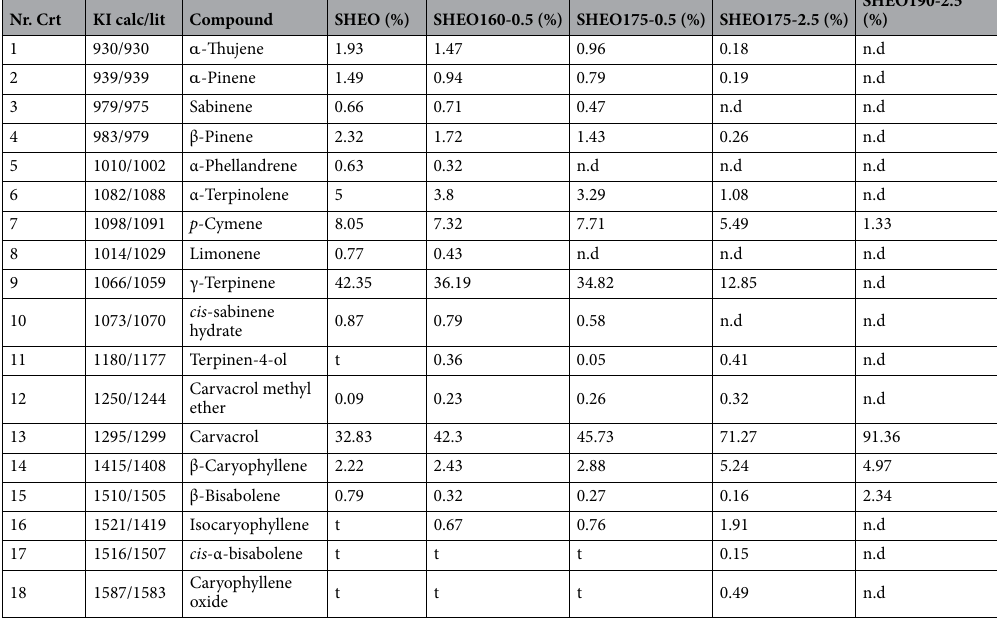
(SHEO160-0.5, SHEO175-0.5, SHEO175-2.5, and